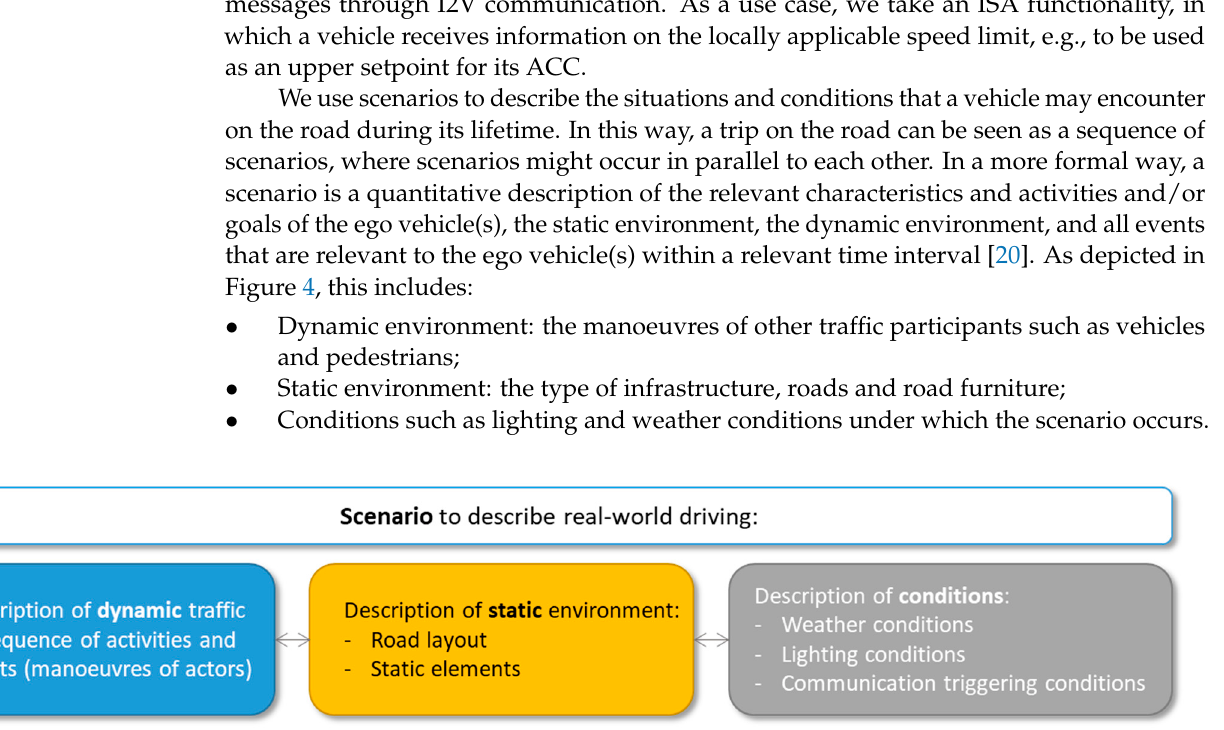
Figure 4. Schematic view [19] on components that describe a real ‐ world scenario in addition to the ego ‐ vehicle’s intention.